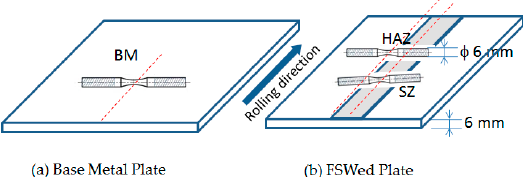
Figure 3. Subtraction of the small round bar specimen: BM: Base metal, SZ: Stir zone at the center of joint, HAZ: Heat affected zone with the lowest hardness.